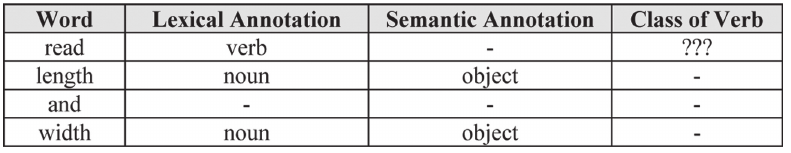
Figure 6: Matrix Structure for Linguistic Analysis of the Information in a Pseudocode